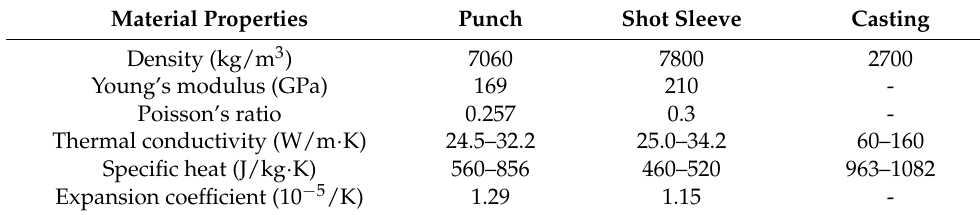
Figure 3. Experimental device: ( a ) Measuring points’ positions; ( b ) testing photo. Note: 1—shot sleeve; 2—preheating ring; 3—micrometer rangefinder; 4—pushing rod; 5—base.